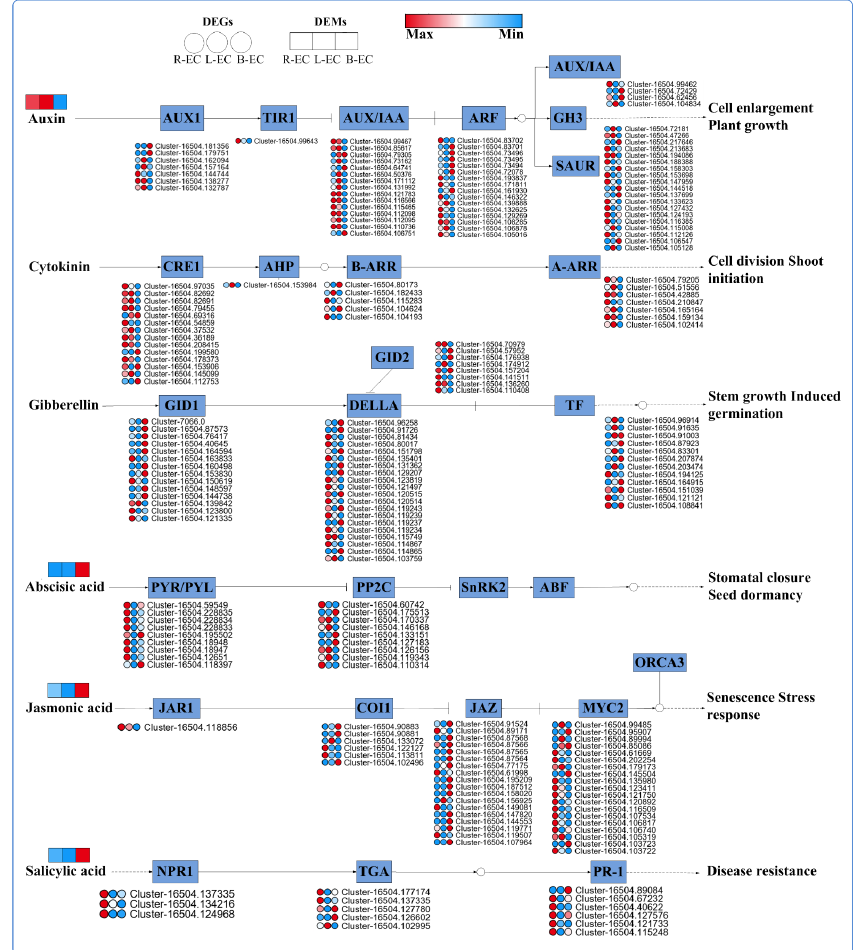
Figure 8. Analysis of plant signal transduction pathways among Korean pine R-EC, L-EC, and B-EC cell lines. Differences in Starch and Sugar Metabolism between Different Cell Lines At the metabolic level, sucrose and UDP-glucose were found to be highly accumu- lated in B-EC, while D-fructose, D-glucose, and D-maltose were found to be highly accu- mulated in L-EC. Glucose-1-phosphate content was higher in R-EC, L-EC, and B-EC, while